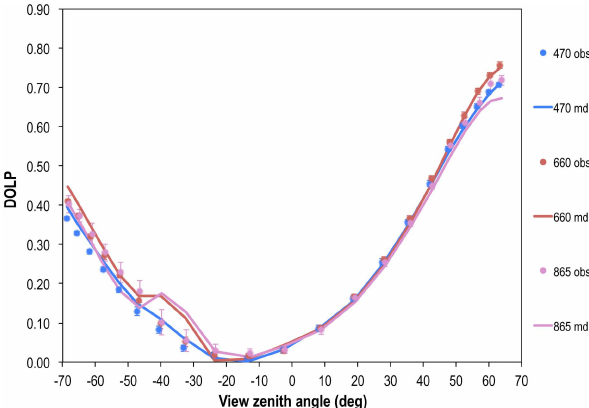
Fig. 12. Same as Fig. 11 but for the bimodal model with 40% of the 558nm optical depth due to a fine mode with 0.03µm median particle radius and 60% due to a coarse mode with 1.00µm median particle radius. Relative to Fig. 11, fits are improved at the most oblique view zenith angles; however, the large particles in the model give rise to a bow between − 30 and − 40 ◦ view zenith angle that is not observed in the AirMSPI